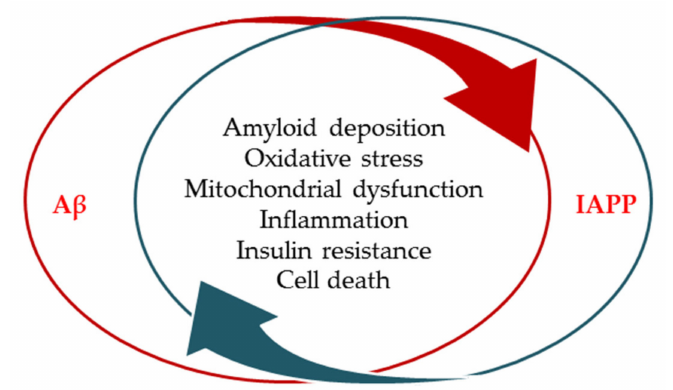
Figure 2. Schematic representation of the correlations between islet amyloid polypeptide of diabetes and amyloid- β peptide from Alzheimer’s disease; conditions characterized by cell loss and abnormal of A β , tau, and amylin deposition. These aggregates could stimulate amyloid formation and deposition by cross-seeding in pancreatic cells and neurons. The presence of tau and amylin aggregates supports the aggregation of beta-amyloid deposits, which leads to oxidative stress, mitochondrial abnormalities, inflammation, insulin resistance, and ultimately death of cells. A β , amyloid- β peptide; IAPP, islet amyloid